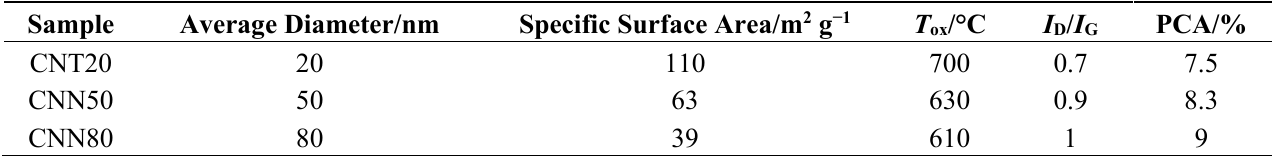
Table 1. Carbon supports’ physical-chemical